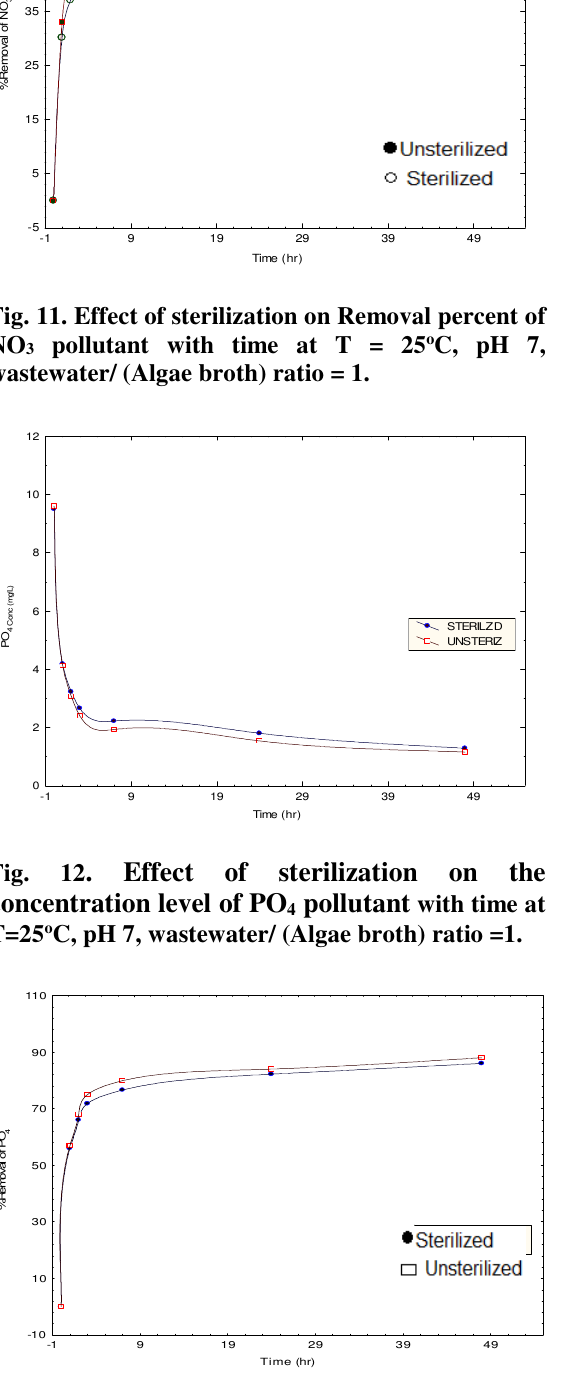
Fig. 13 . Effect of sterilization Removal percent of PO pollutant with time at T=25 o C, pH 7, 4 wastewater/ (Algae broth) ratio = 1.